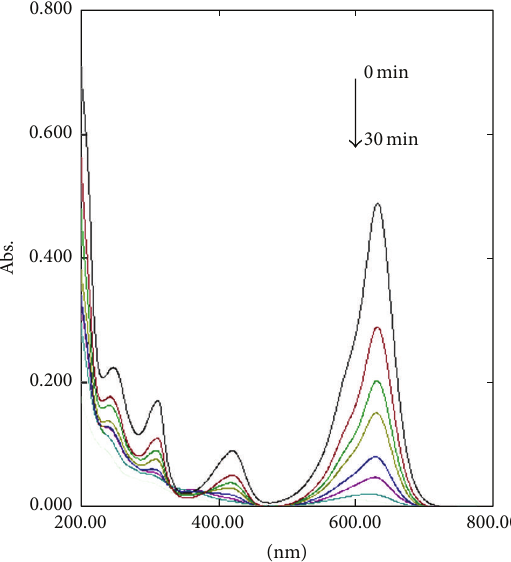
Figure 9: Evolution of UV-Vis spectra of Methyl Green (MG) aqueous solution with reaction time (initial concentration of MG = 75 mg, photocatalyst amount = 0.75 g, HP = 8 mL, and irradiation time = 30 min at pH =